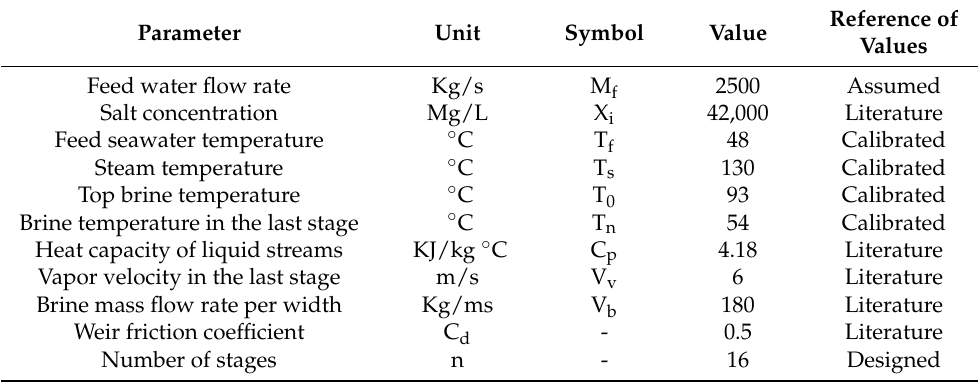
Table 1. Technical design parameters used in the